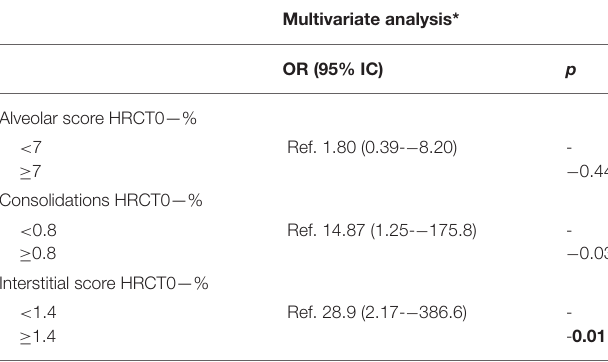
TABLE 4 | Multivariate analysis for factors independently associated with radiological sequelae at follow-up in patients hospitalized for SARS-COV-2-related